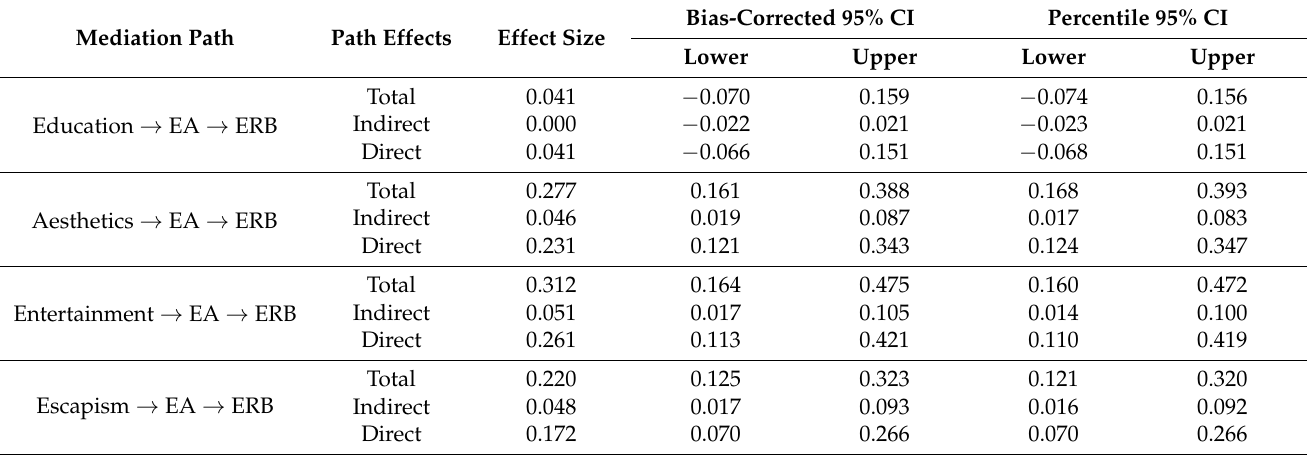
Table 5. Result of mediating effect